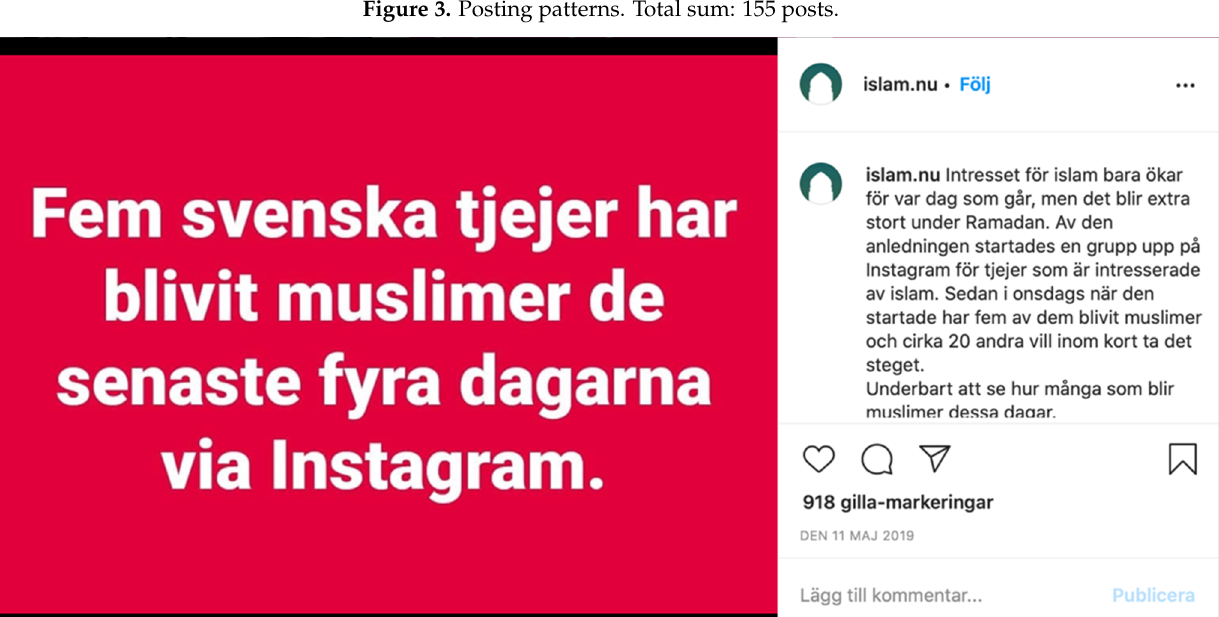
Figure 3. Posting patterns. Total sum: 155 posts.